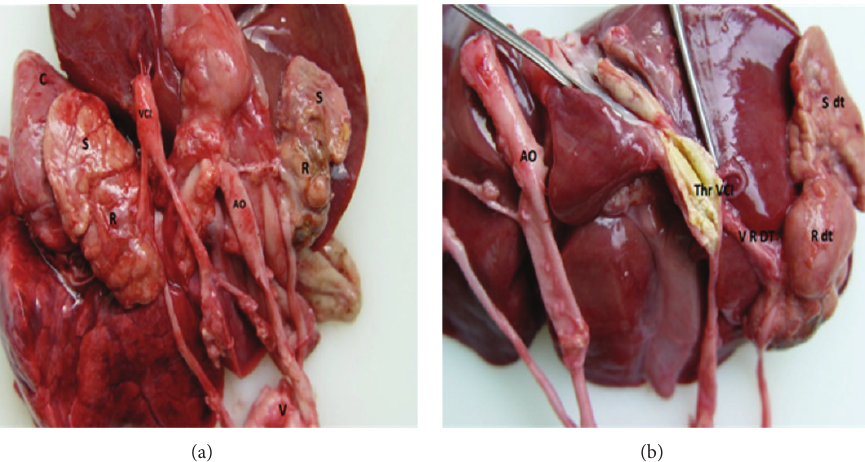
Figure 1: Vena cava with thrombosis occupying most of its length. Severe right renal hypotrophy, compared to the left kidney (R: kidney; S: adrenal gland; AO: aorta; VCI: inferior vena cava; R dt: right kidney; S dt: right adrenal gland).